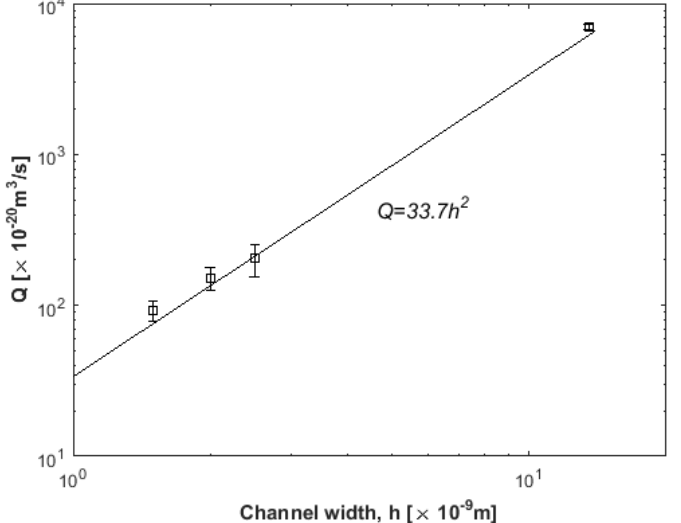
ion separation model of Figure 2. A line is a linear fit.